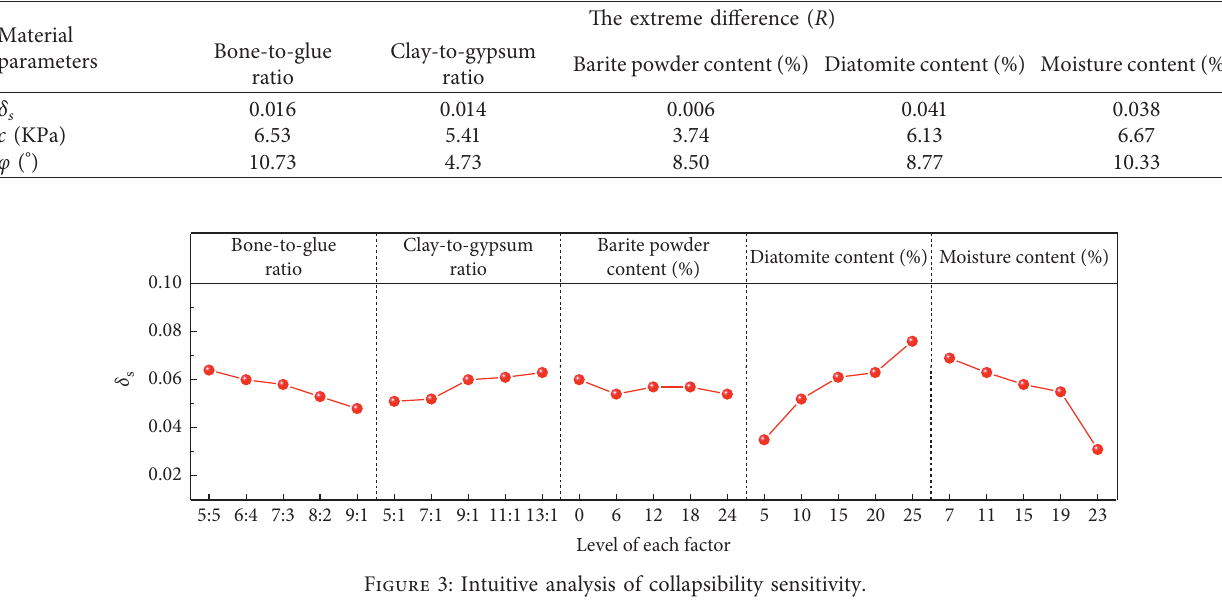
Table 3: Range analysis of each factor.